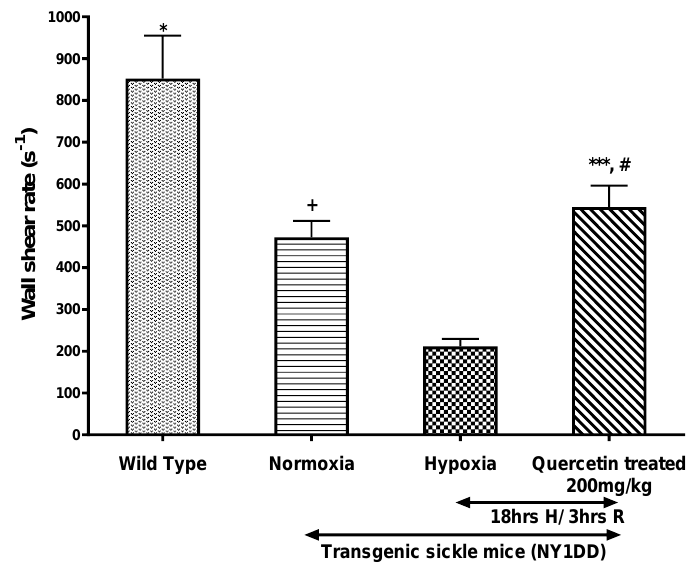
Figure 4. The effect of a single dose of quercetin (200 mg/kg, i.p.) on the wall shear rate in wild type and NY1DD transgenic sickle mice under normoxia and hypoxia conditions. Values represent the mean ± SEM for four animals in each group; + p < 0.03 vs. normoxic wild type controls; * p < 0.0001 as compared to H/R-induced NY1DD mice; # non-significant vs. normoxic NY1DD mice; *** p < 0.0001 vs. NY1DD mice subjected to H/R (untreated).